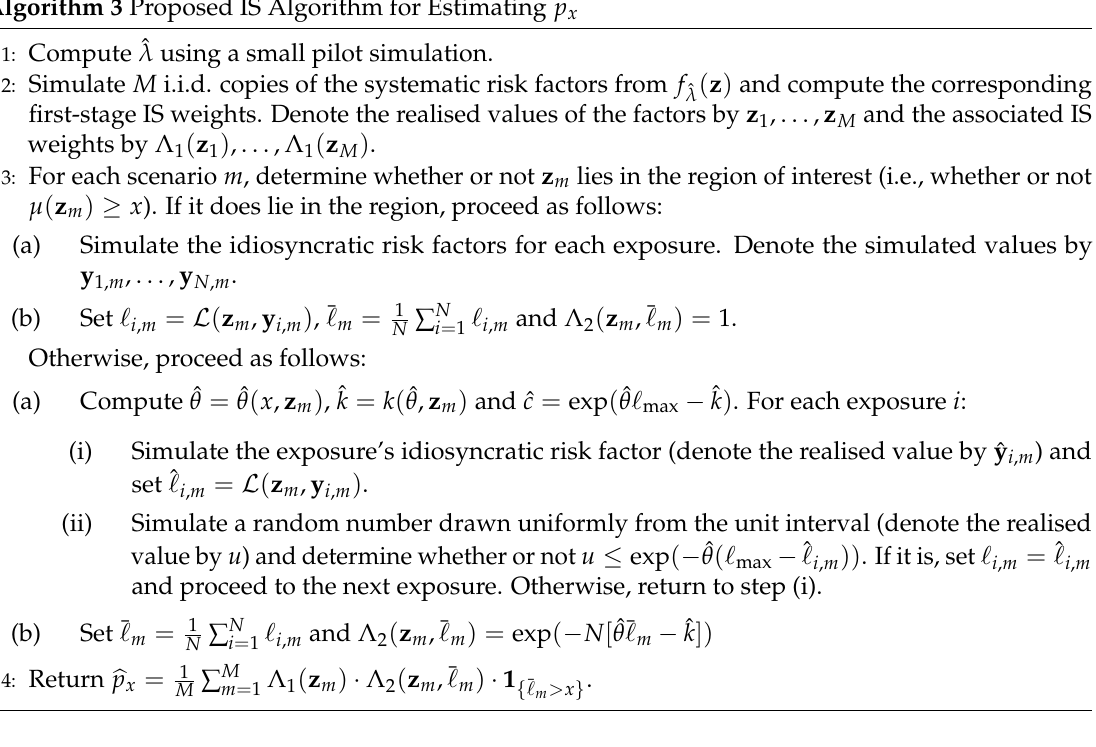
Algorithm 3 Proposed IS Algorithm for Estimating p